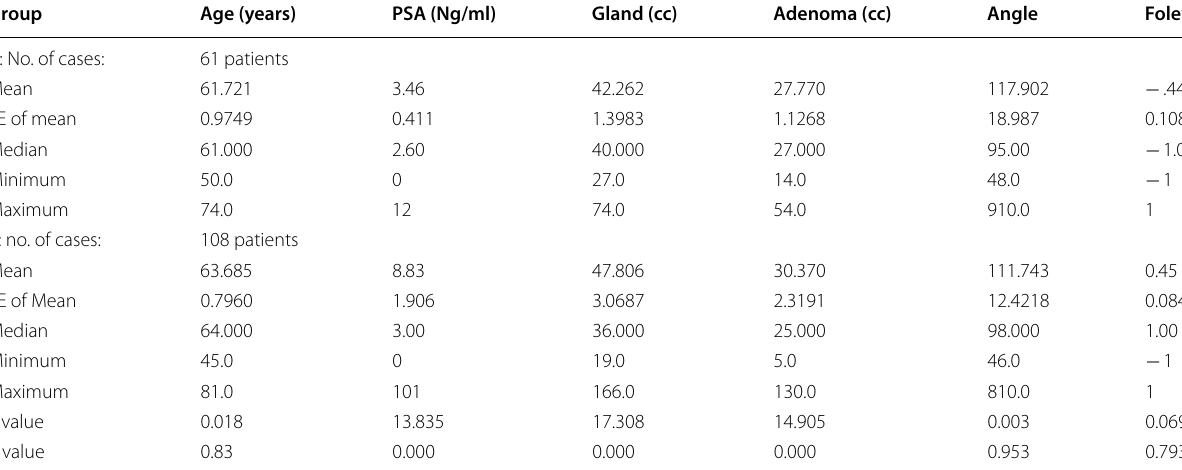
Table 1 Comparison between two groups